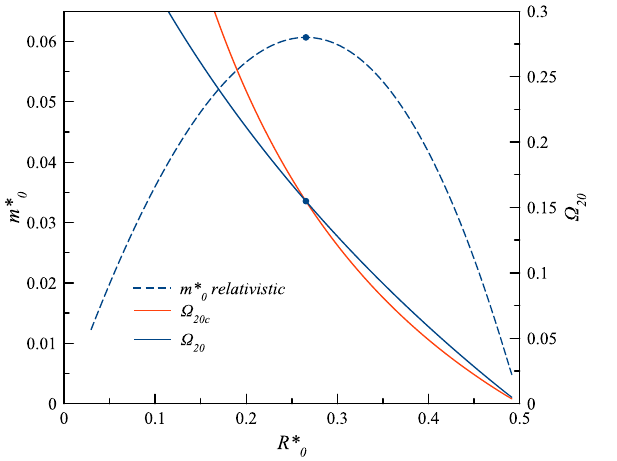
m ∗ → 0 and R ∗ → 0. The DEC is satisfied along the whole curve as expected, together with the constraint 2 m ∗